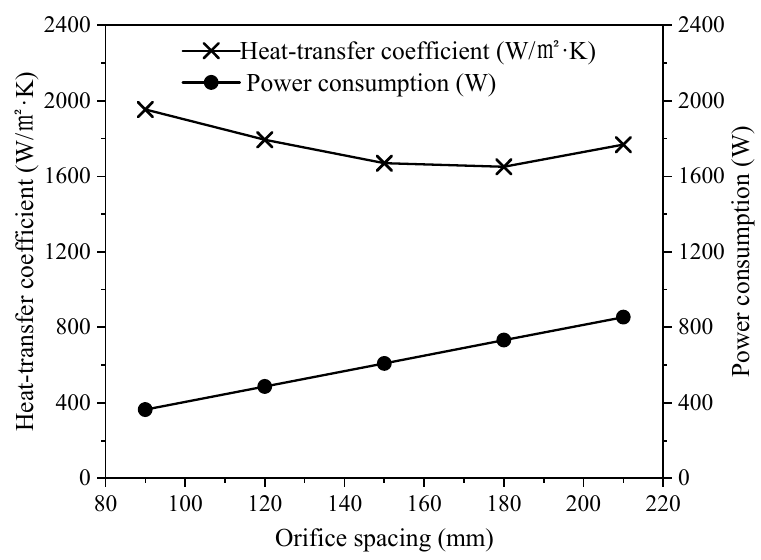
Figure 18. Heat transfer coefficient and power consumption changes at different orifice